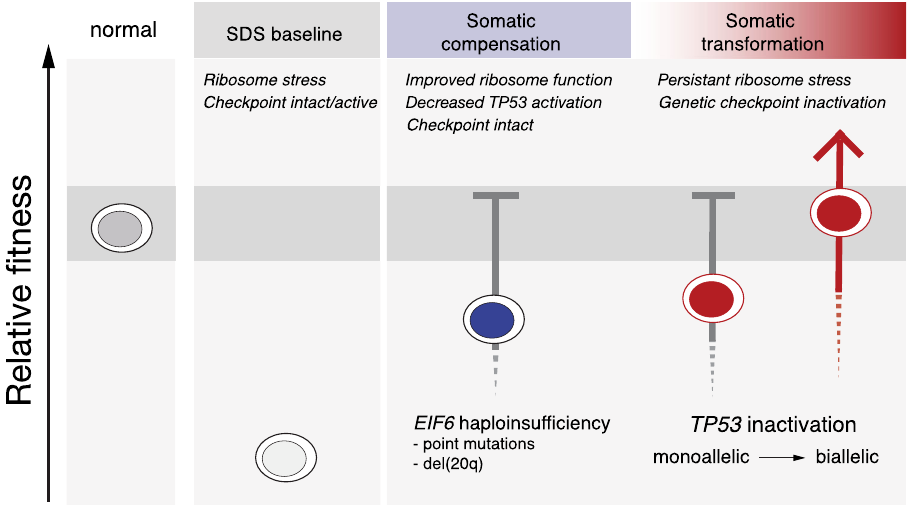
Fig. 7 TP53 and EIF6 mutations de fi ne distinct pathways of somatic clonal progression and distinguish leukemia predisposition in SDS. Germline context drives separate compensatory and maladaptive somatic pathways of clonal evolution in patients with SDS. Germline SBDS mutations result in ribosomal stress which activate TP53 checkpoint pathways and promote bone marrow failure. EIF6 mutations alleviate the underlying ribosome maturation defects which reduces p53 checkpoint activation and improves cell fi tness. TP53 mutations eliminate checkpoint pathways to improve relative fi tness without improving the underlying ribosomal abnormalities, and promote the development of myeloid